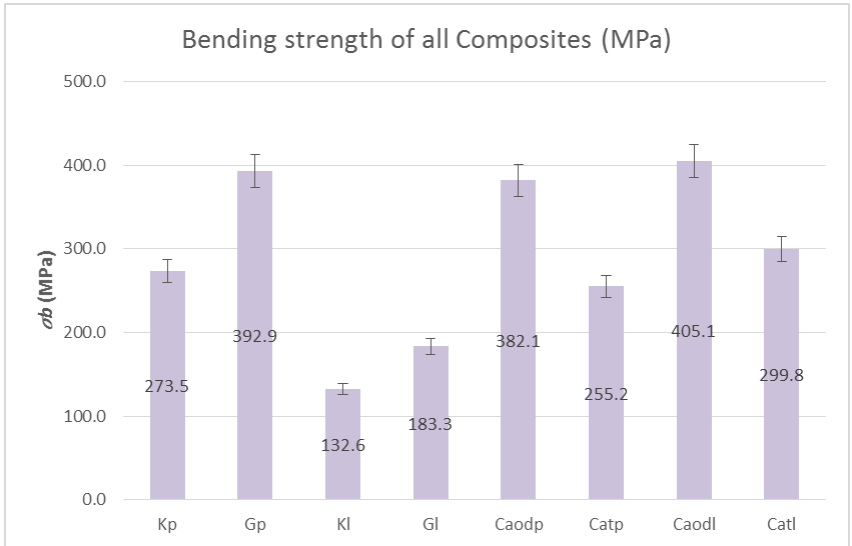
Figure 15. Bending strength of epoxy resin-reinforced specimens (reinforced with carbon fiber, glass fiber and Kevlar fabrics). Variation of values: ±5%.